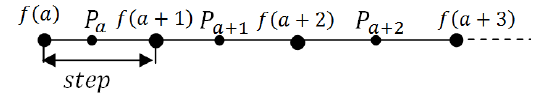
Figure 1. The distribution of